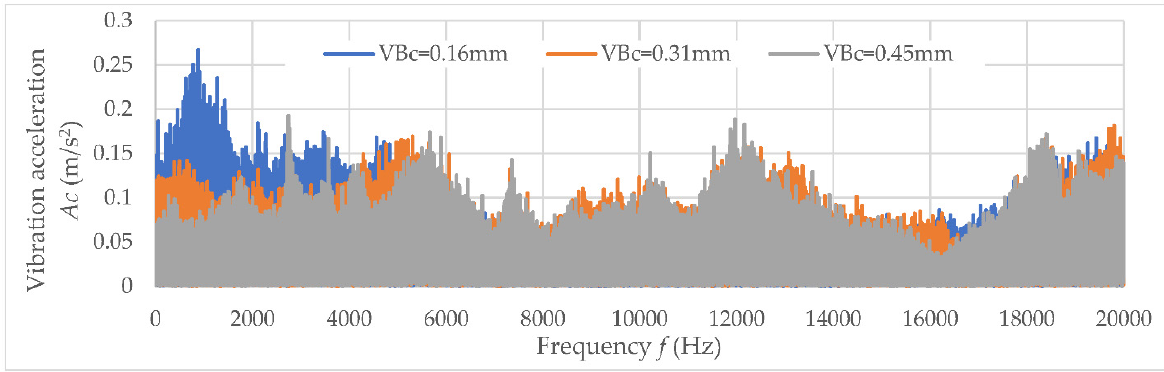
Figure 9. The amplitude-frequency characteristics for main analyzed direction